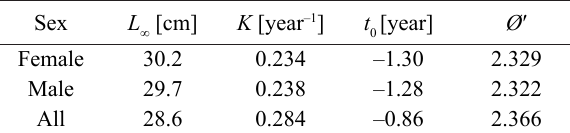
Parameters ( L∞, K , and t ) of the von Bertalanffy growth 0 curve and growth performance indexes ( Ø ′) for male, female, and all sand steenbras in the Köyceğiz